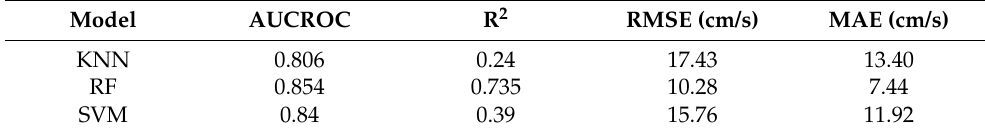
Table 5. Comparison of the predictive performance for three models (fivefold cross-validation).